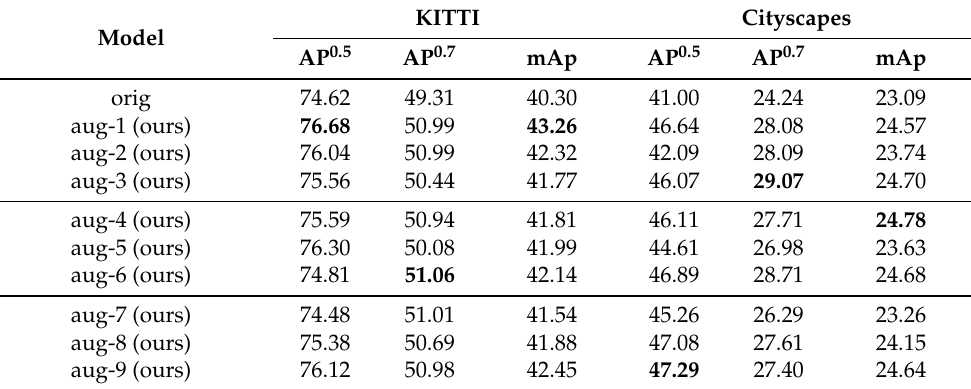
Table 3. mAP of car detector trained on different samples. Numbers in bold indicate the best result in the